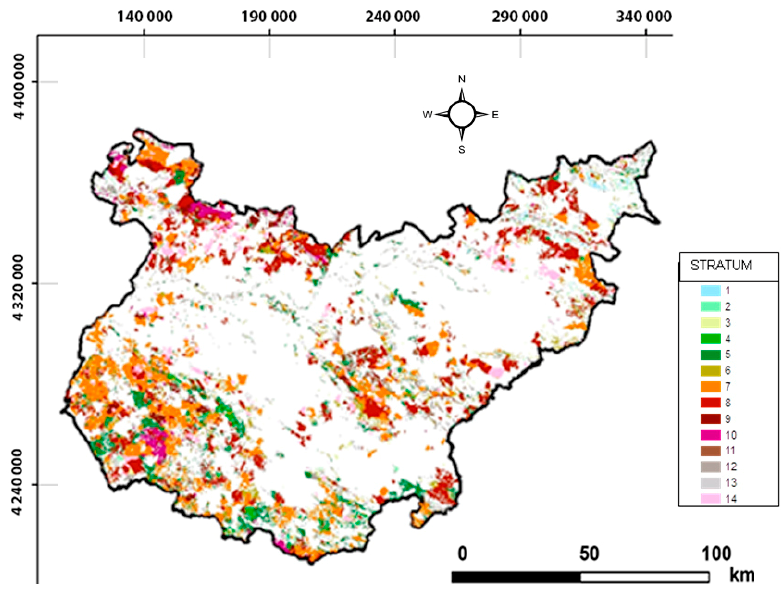
Figure 4. Distribution of strata in the province of Badajoz.